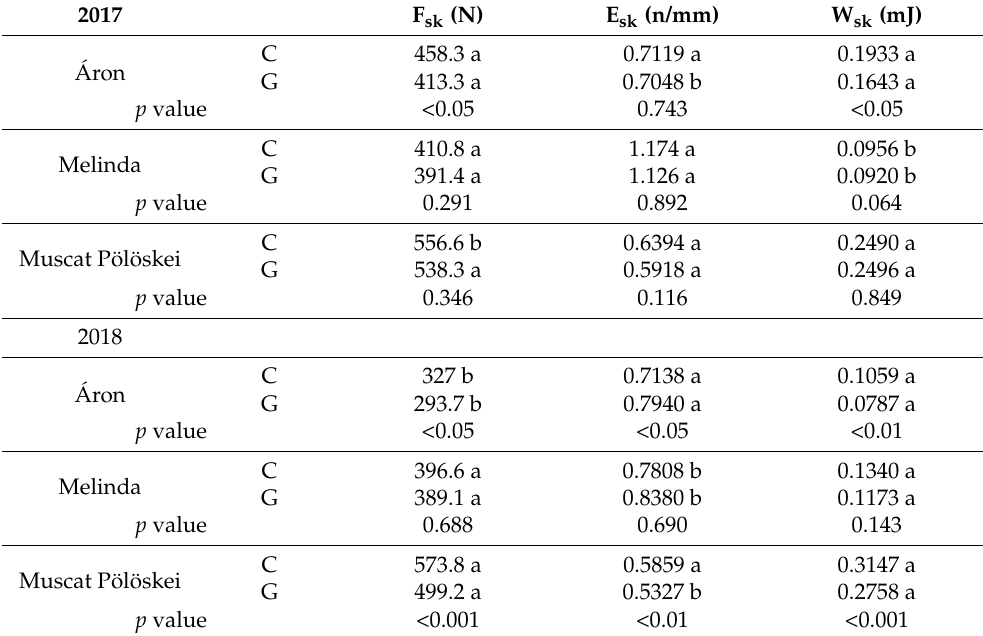
Table 3. Results of the berry skin puncture test in the experimental years (2017,